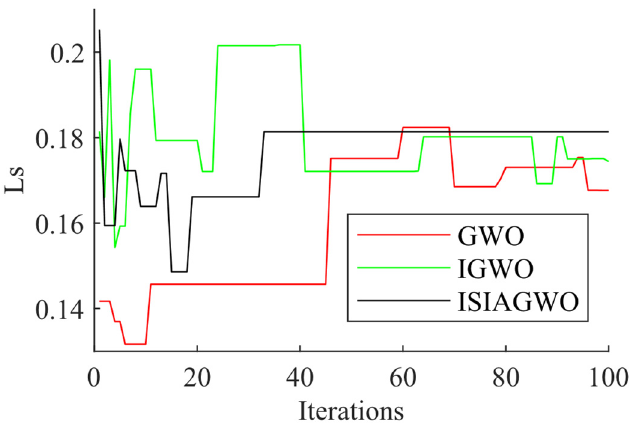
Figure 15. The stator inductance of DFIG identification convergence curve. The rotor inductance of DFIG identification convergence curve, shown in Figure 16.